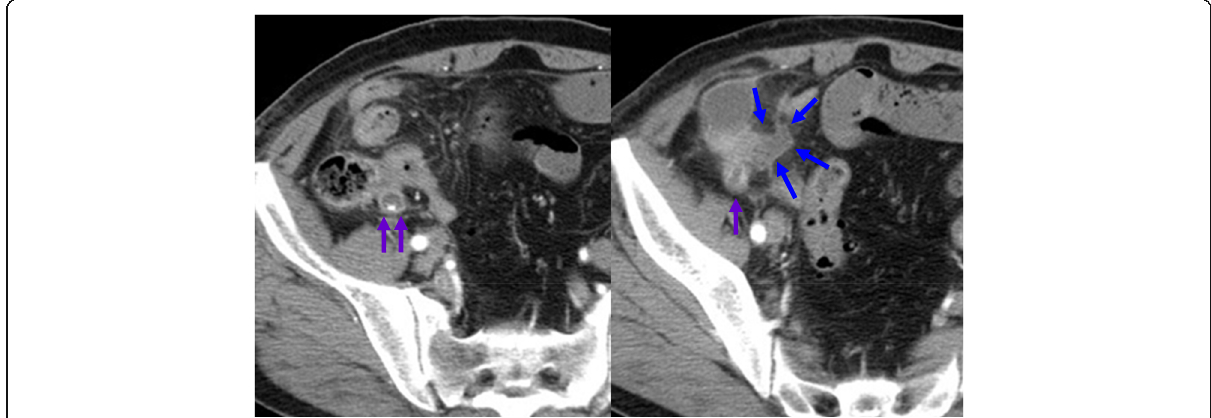
Fig. 2 CT findings of acute appendicitis. A swollen appendix (purple arrows) was observed, and fluid collection (blue arrows) near the